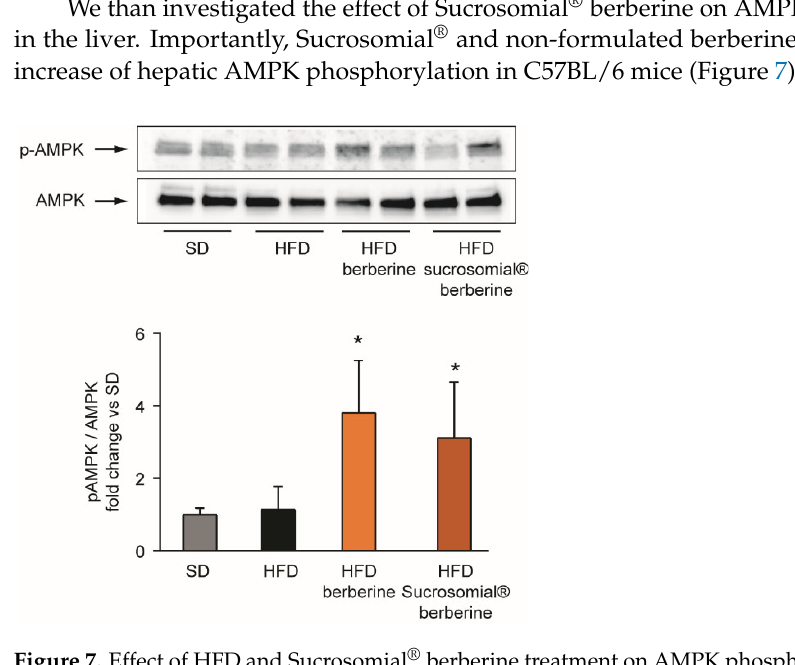
Figure 6. Effect of HFD and Sucrosomial ® berberine treatment on glucose levels during OGTT test in C57BL/6 mice after 16 weeks of diet and 8 weeks of treatment. HFD: high ‐ fat diet; OGTT: oral glucose tolerance test.